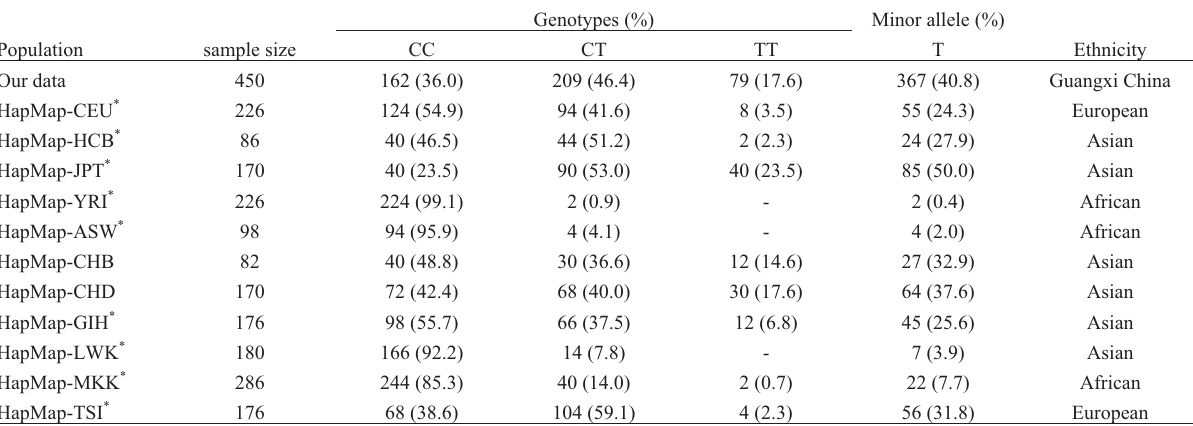
Table 3 - Comparison of the rs1883832 polymorphism in different